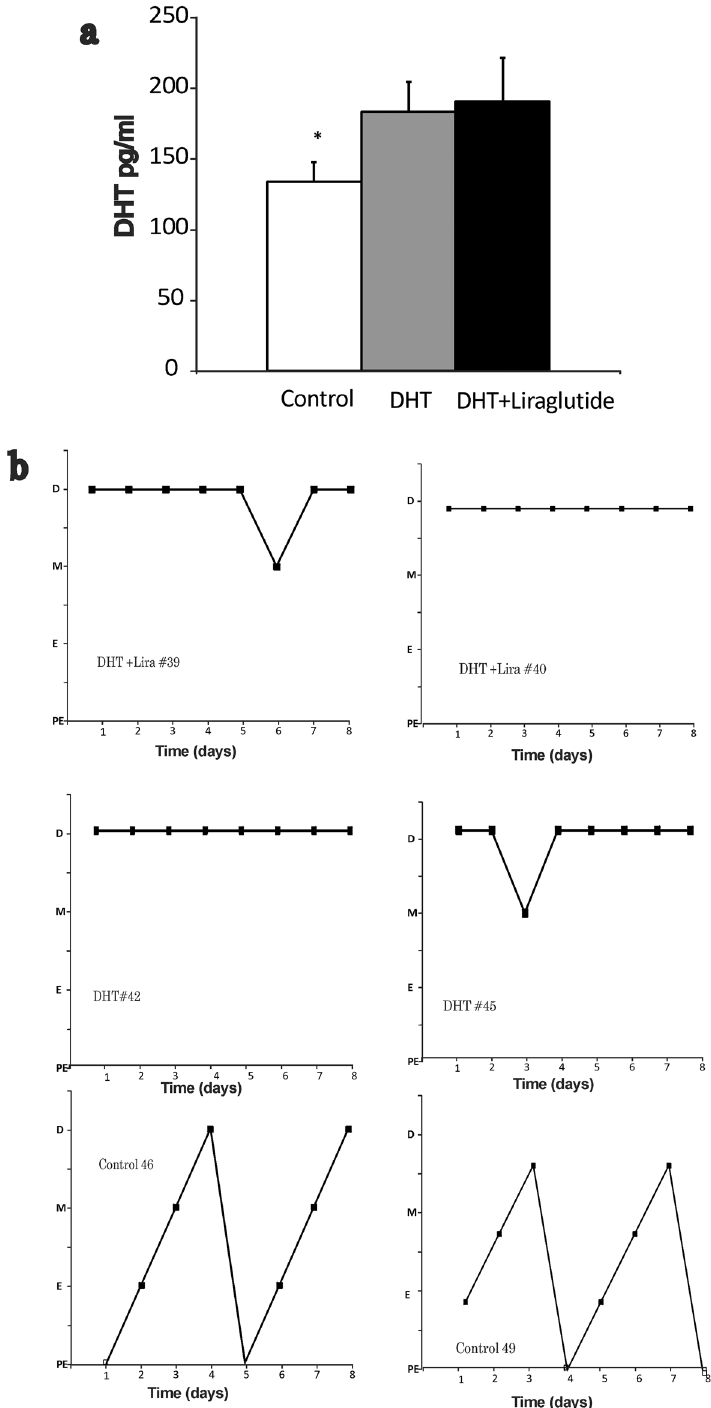
Fig 1. DHT levels and estrous cycle pattern: a) DHT levels measured at 16 weeks of age. (Mean ± SEM; pg/ml) : measured in the serum by ELISA, control group (n = 9) DHT group (n = 10) and DHT+ liraglutide group (n = 11). DHT levels were 1.3 fold higher in the DHT treated rats compared to control irrespective of liraglutide treatment (p < 0.05). b) Estrous cycle pattern in the three groups. Vaginal cytology was done every day starting at 8 week of life till the end of the study. Data presented are from the last week of the study. The figure shows pattern of two representative rats in each group including control, DHT and DHT + Liraglutide. P: proestrus; E: estrus; M: metestrus; and D: diestrus.